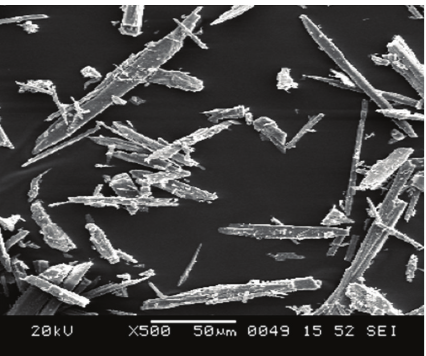
Figure 1: SEM picture of PTW